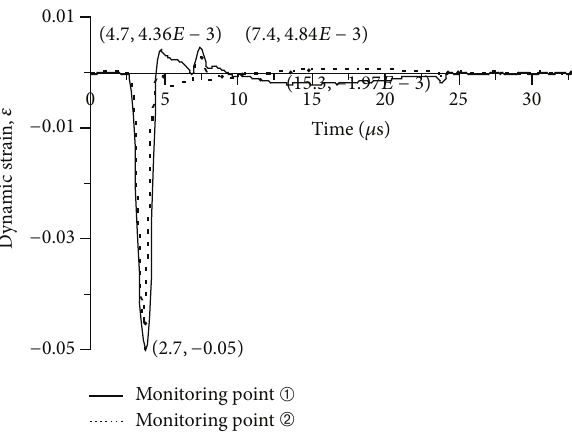
Figure 2: Complete time-strain curves of blasting